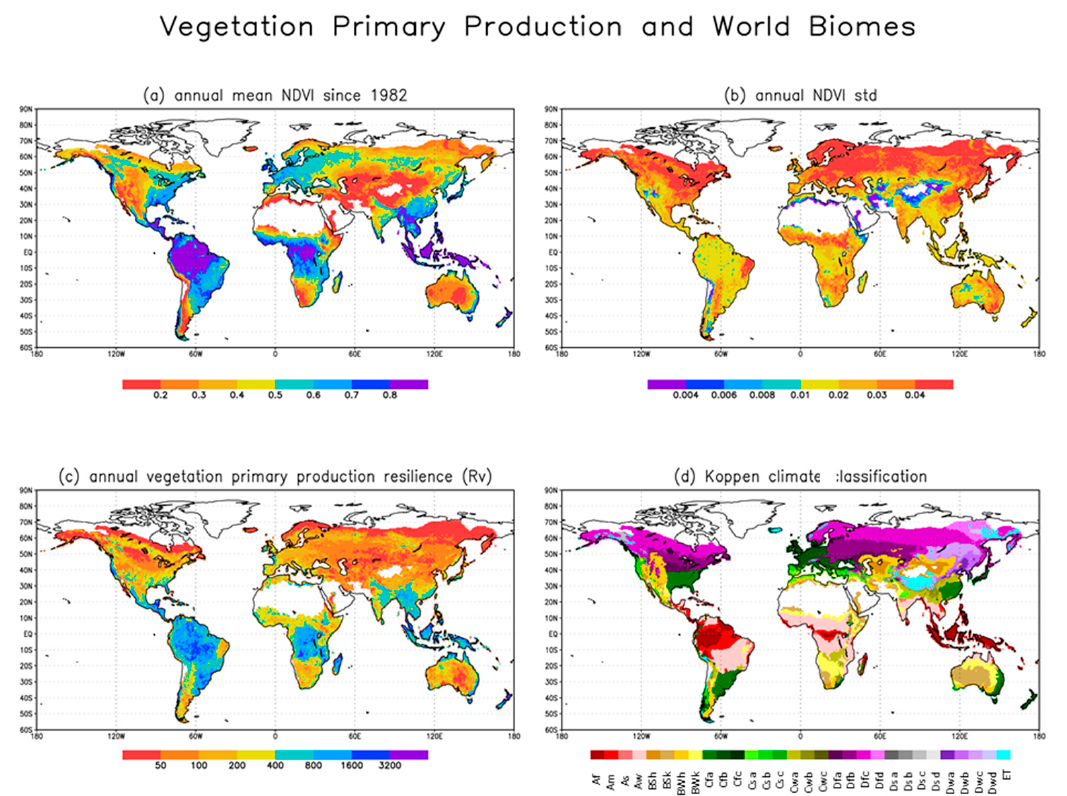
Figure 3. Analysis of annual mean NDVI remotely sensed data for the period 1982–2015: ( a ) long-term climatology; ( b ) standard deviation; ( c ) annual vegetation primary production resilience indicator ( R V ); ( d ) spatial distribution of world biomes according to the Köppen–Geiger (KG) classification.